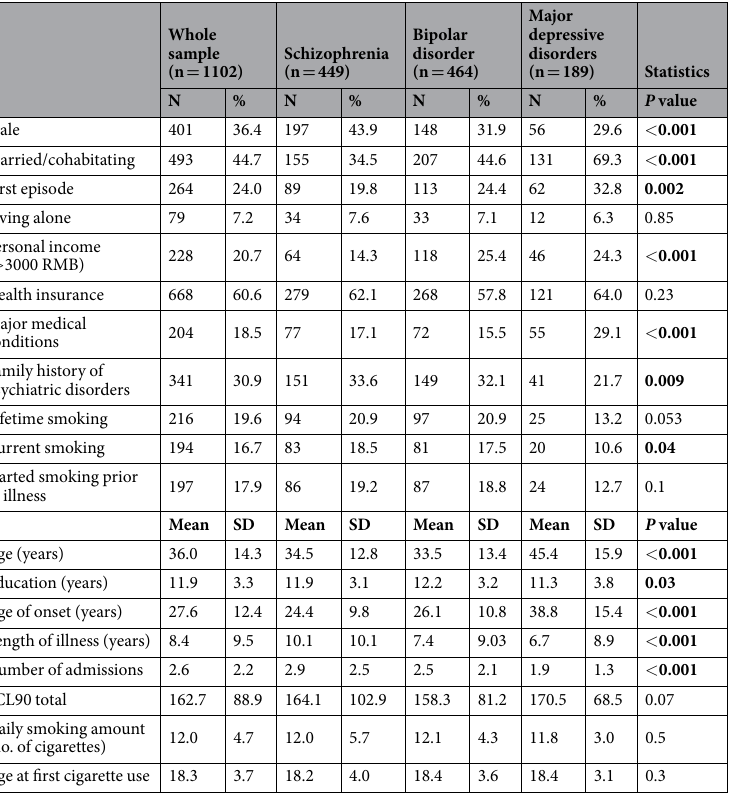
Table 1. Basic socio-demographic and clinical characteristics of the study sample. Bolded values: < 0.05; Kruskal-Wallis H test was used to compare continuous variables; 1 USD = 6 RMB; SCL-90 = Symptom Checklist-90; SF-12 = Medical Outcomes Study Short Form. The one-sample Kolmogorov-Smirnov test was used to check the normality of distribution for continuous